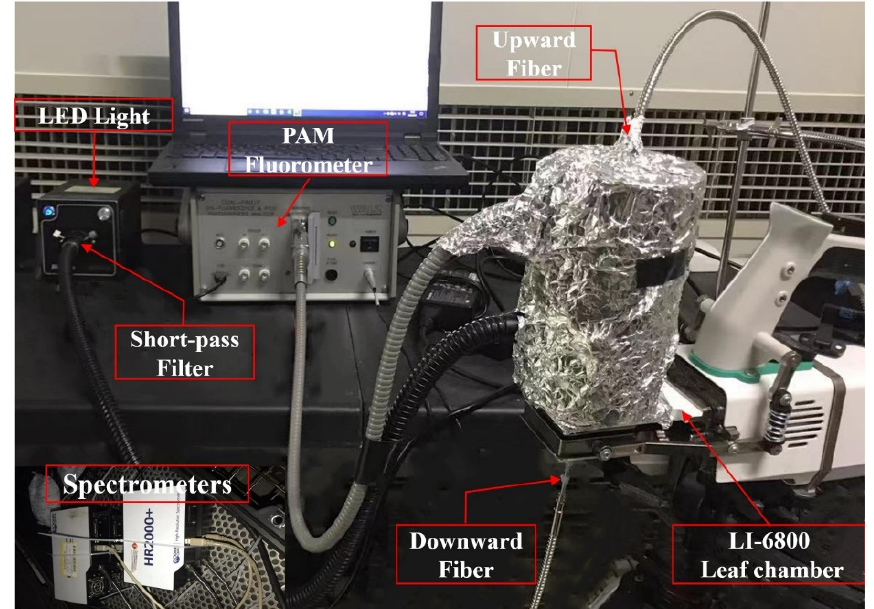
Figure 1. Photograph of the practical synchronous measurement system. The picture demonstrates a custom-made leaf chamber system for concurrent fluorescence measurements on a leaf sample under various environmental factors. It shows the main components in this system, including an LED light source with a short-pass filter, a PAM fluorometer, an LI-6800 gas exchange system, and four spectrometers with two bundled fibers.